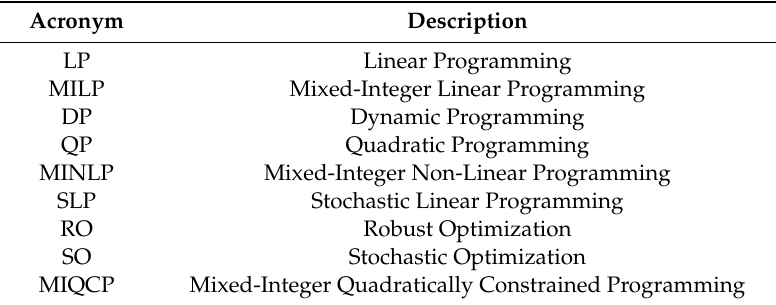
Table A1. Mathematical programming techniques.